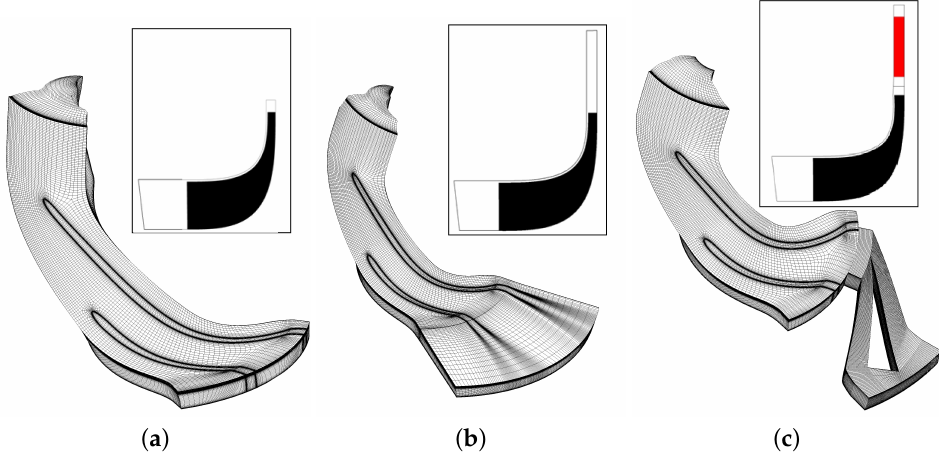
Figure 3. Computational domains for different centrifugal compressor configurations. Inset figures represent the meridional geometry. ( a ) Impeller alone. ( b ) Impeller with vaneless diffuser. ( c ) Impeller with vaned